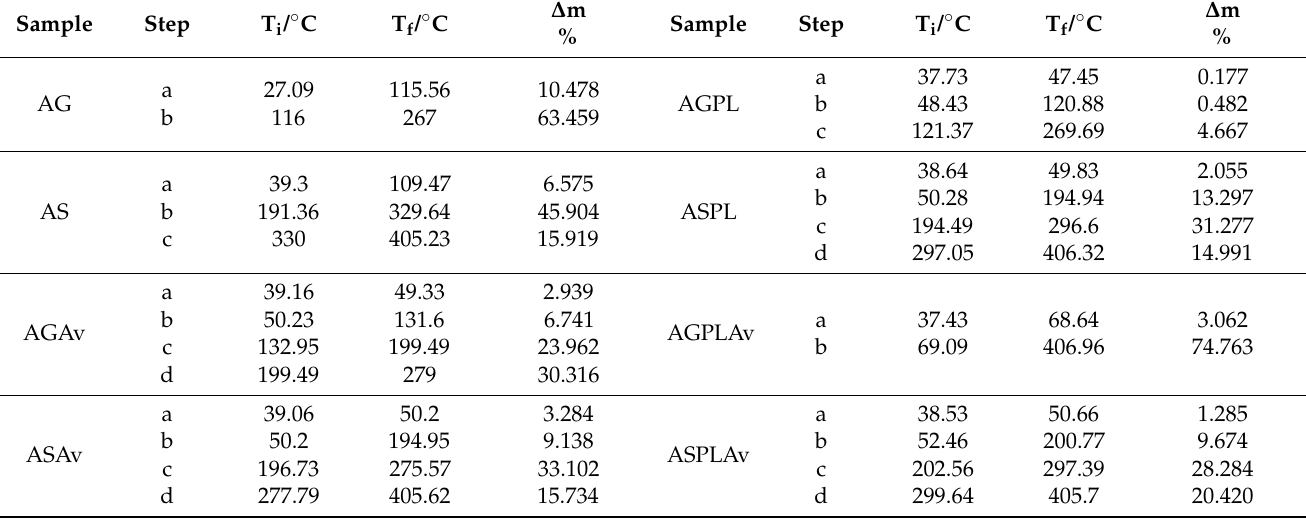
Table 2. Thermogravimetric data for the decomposition stages of